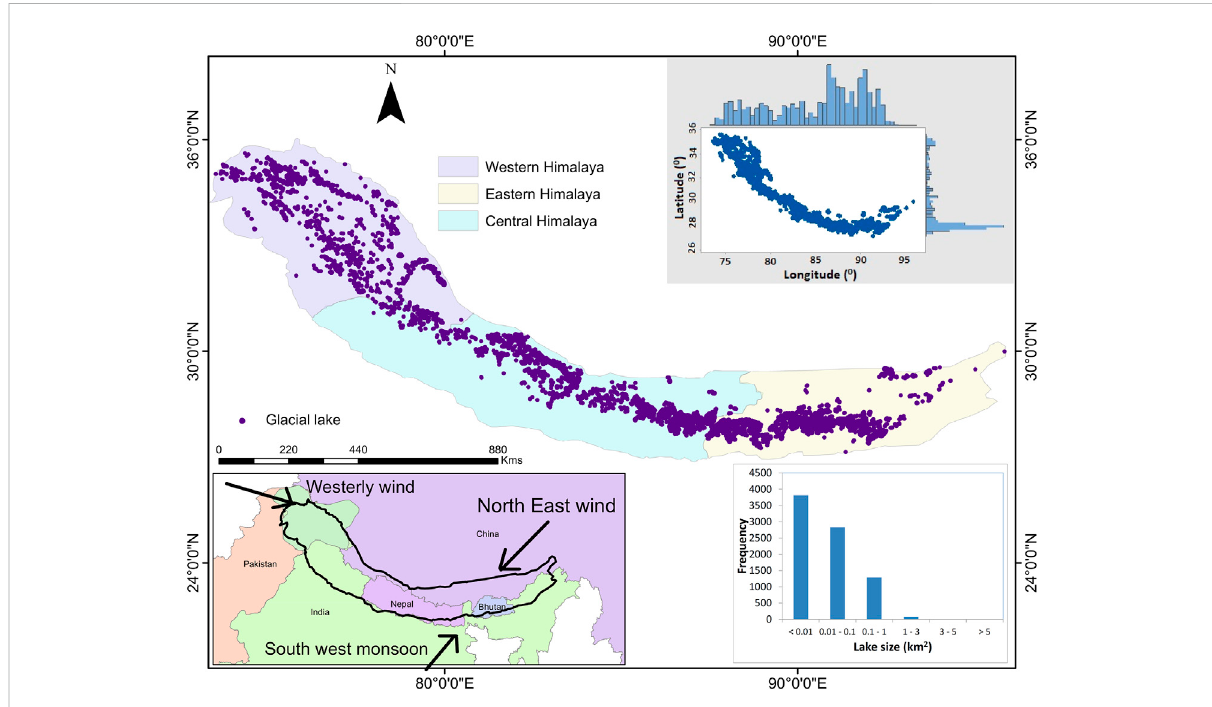
FIGURE 1 The Himalaya is taken as study area; here, dot with brown color shows the lake position in the study area. The violet color boundary shows the study area extent. Here, the scatter plot in the upper right corner shows the lake distribution along the latitude and longitude in the Himalaya, the histogram inthelower-leftcornershowsthelakesizedistributionintheHimalaya.Lakefrequencydistributionwasalsoshowninanothergraphwith respect to elevation.